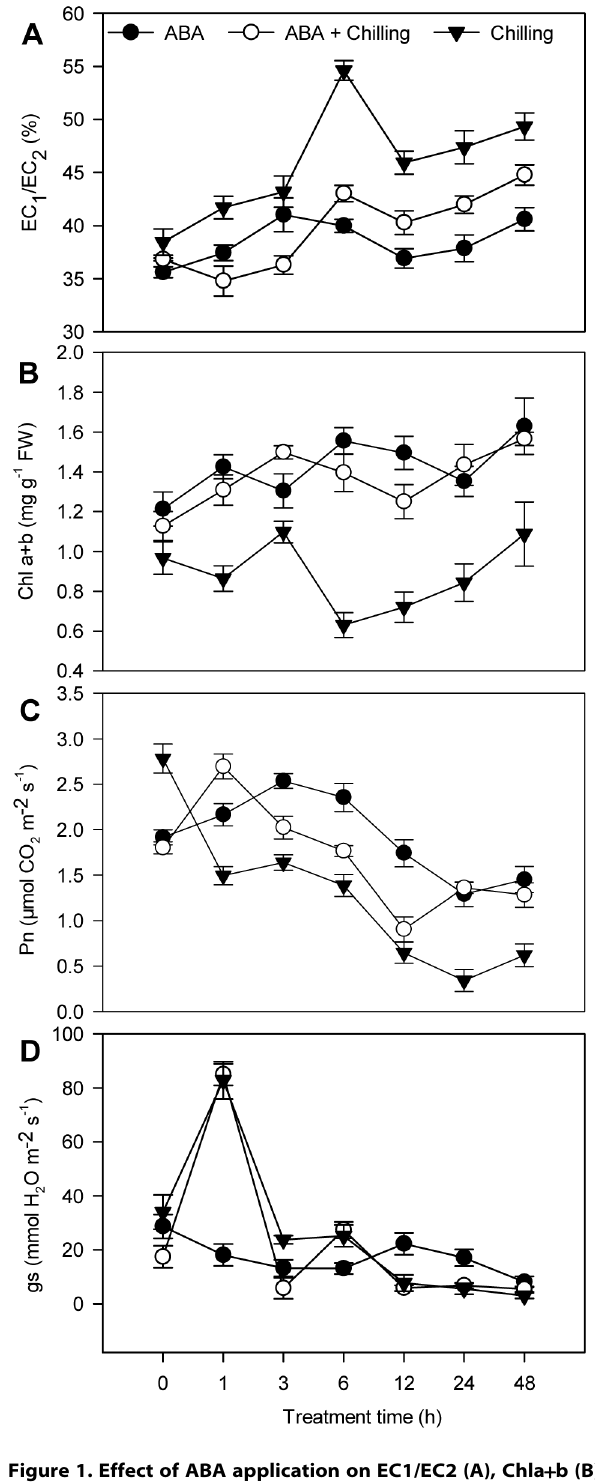
Figure 1. Effect of ABA application on EC1/EC2 (A), Chla + b (B), Pn (C) and g s (D) . 72 hours after application of 0.57 mM abscisic acid (ABA) by foliar spray, the plants were subjected to chilling stress at 6 u C (day/night). Values are means 6 SE (n=4). Closed circle: ABA- pretreated samples under room temperature; open circle: ABA-sprayed samples prior to chilling stress; triangle down: water-sprayed samples prior to chilling stress.